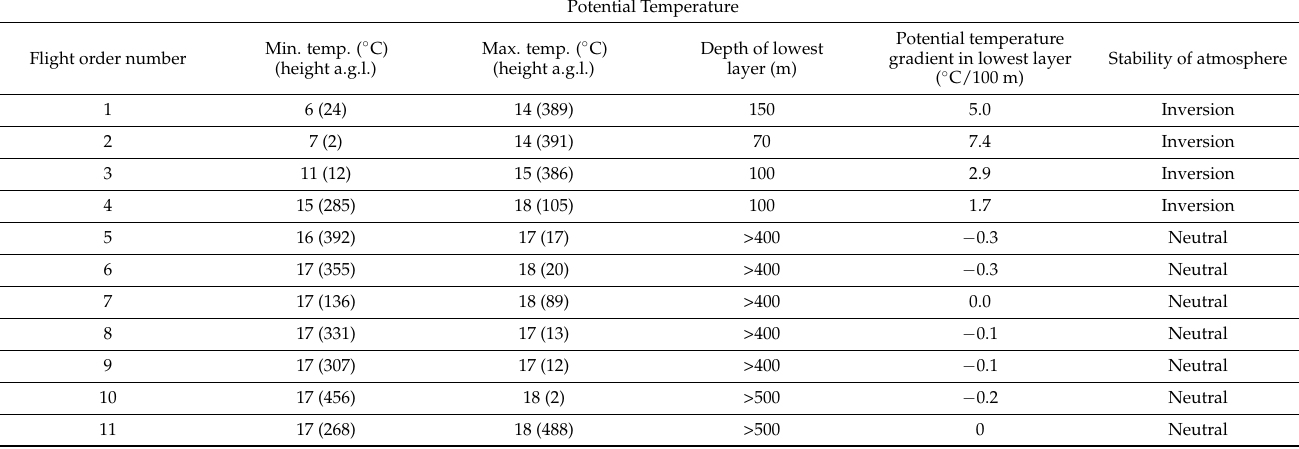
Table A4. Stability of atmosphere on 7 March